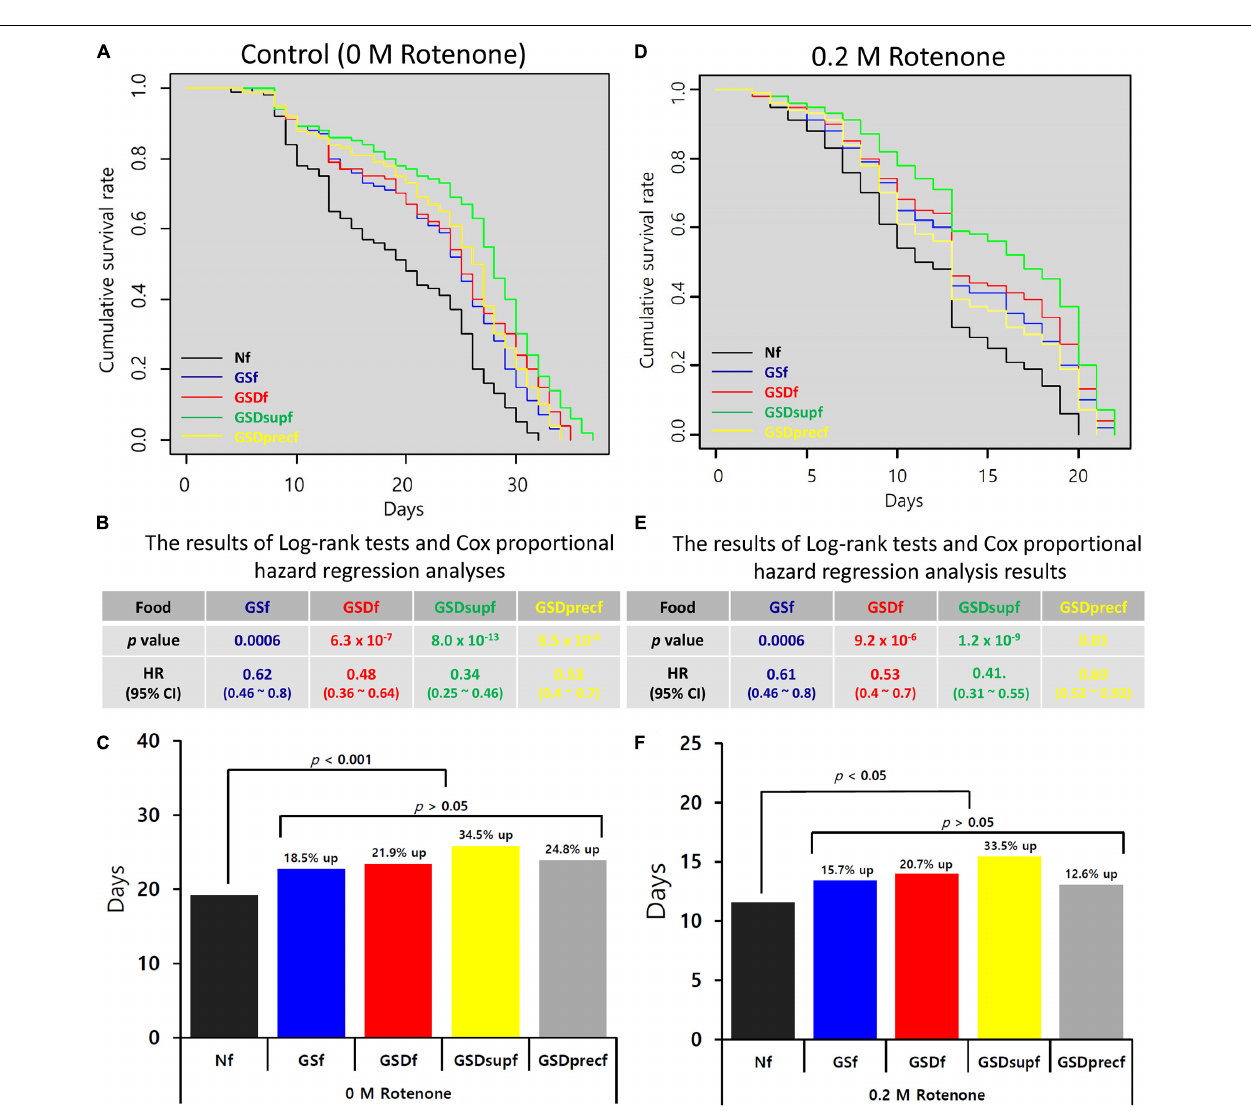
FIGURE 3 | Prevention of the onset and progression of rotenone-induced loss of motor control by GS, GSD, GSDsup, or GSDprec. (A) The lifespans of GSf, GSDf, GSDsupf, or GSDprecf-reared Drosophila were extended compared with that of Nf-reared Drosophila. (B) In comparison with Nf-reared Drosophila , the HRs of Drosophila reared with GSf, GSDf, GSDsupf, or GSDprecf were significantly reduced, when they were not treated with rotenone. (C) The average lifespans of GSf-, GSDf-, GSDsupf-, or GSDprecf-reared Drosophila were more promoted than that of Nf-reared Drosophila . (D) When Drosophila was exposed to 0.2 M rotenone, the lifespans of GSf, GSDf, GSDsupf, or GSDprecf-reared Drosophila were extended compared with that of Nf-reared Drosophila. (E) The HRs of GSf-, GSDf-, GSDsupf-, and GSDprecf-reared Drosophila were significantly reduced. (F) The average lifespans of GSf-, GSDf-, GSDsupf-, and GSDprecf-reared Drosophila were more promoted than that of Nf-reared Drosophila